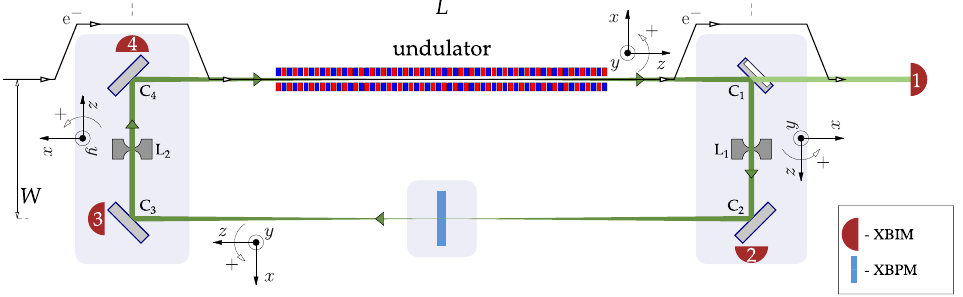
FIG. 1. Schematic of a cavity-based XFEL with an undulator x-ray source together with a four-crystal (C 1 – C 4 ), two-lens (L 1 – L 2 ) rectangular x-ray cavity and x-ray diagnostics [23]. Cavity round-trip length 2 ð L þ W Þ ≃ 65 m. X-ray diagnostics tools include x-ray beam intensity monitors (XBIMs) and an x-ray beam position, profile, and intensity monitor